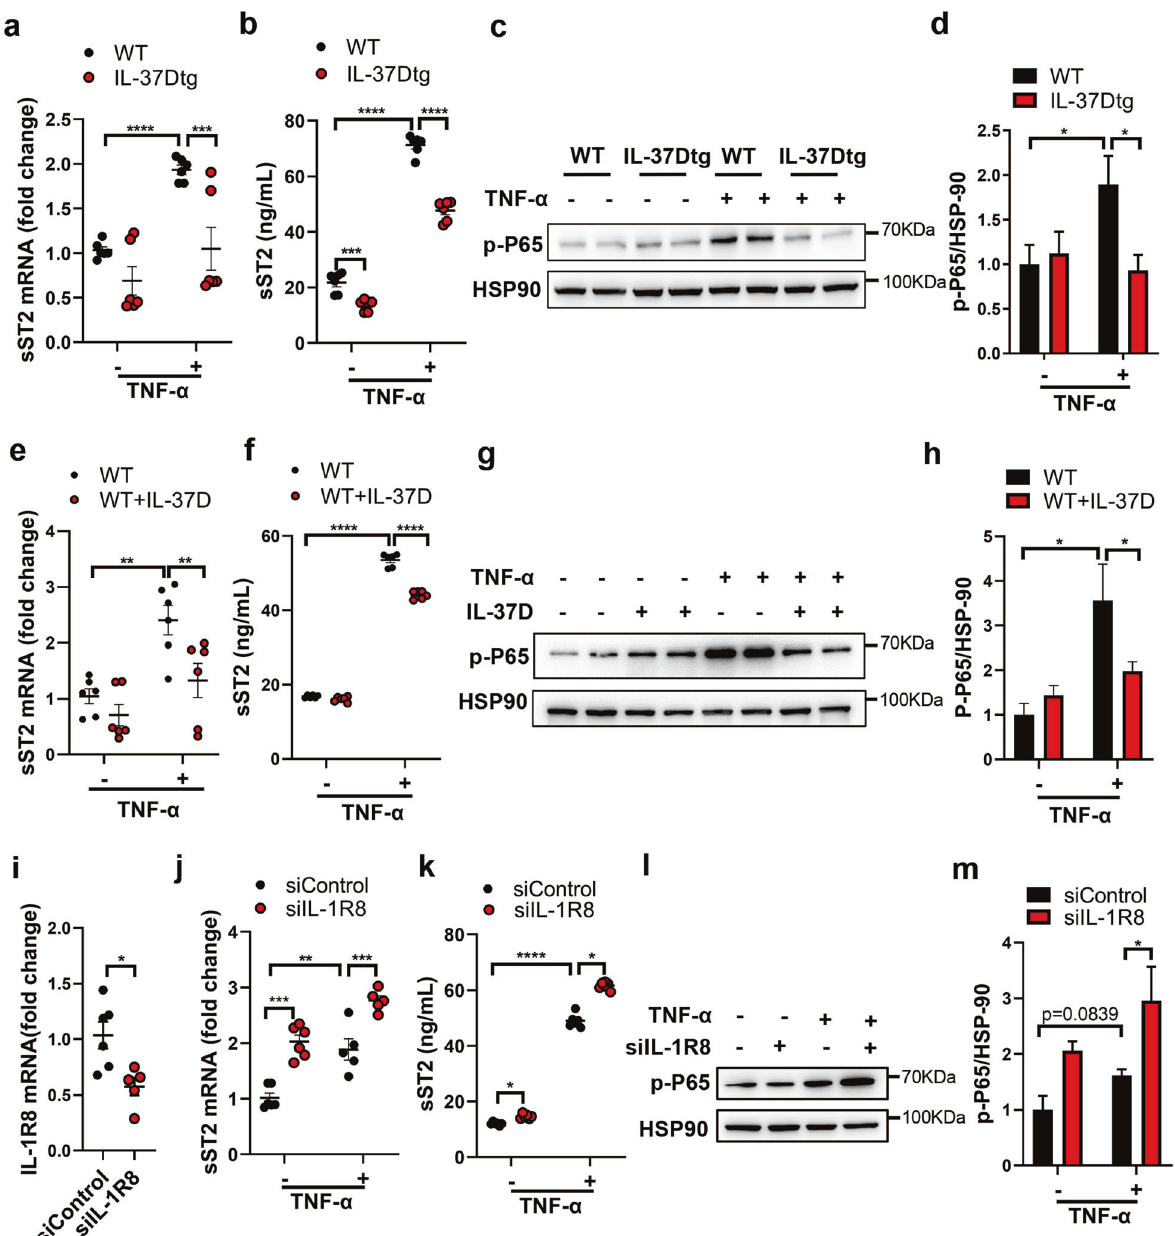
Fig. 7 IL-37D inhibits sST2 production in IL-1R8-dependent manner. a – d ADSCs (1 × 10 5 /mL) from inguinal WAT of WT and IL-37Dtg mice were stimulated by TNF- α (10 ng/mL) for 24 h. The mRNA ( a ) and secretion ( b ) levels of sST2 were detected by qPCR and ELISA. The protein level of p-P65 was detected by western blot ( c ), the grayscale values are shown ( d ). e – h ADSCs from inguinal WAT of WT mice were treated with IL-37D protein (1 ng/mL) in the presence or absence of TNF- α (10 ng/mL) for 24 h. The mRNA ( e ) and secretion ( f ) levels of sST2 were detected by qPCR and ELISA. The protein level of p-P65 was detected by western blot ( g ) and the grayscale values are shown ( h ). IL-1R8 was silenced in ADSCs from IL-37Dtg mice, the mRNA levels of IL-1R8 ( i ) and sST2 ( j ) were detected by qPCR, the secretion level of sST2 was detected by ELISA ( k ), and the protein level of p-P65 was detected by western blot ( l ) and the grayscale values are shown ( m ). Data in a – m are representative of three independent experiments. Data represent mean ± SEM. * p < 0.05, ** p < 0.01, *** p < 0.001, **** p < 0.0001 determined by two-way ANOVA ( a , b , d – f , h , j , k , m ) or student ’ s t test ( i ). Quantitative PCR Western blot assay Total RNA was extracted with TRNzol reagent according to the Proteins from lysed cells or tissues were separated on SDS-PAGE gel and manufacturer ’ s instruction (Tiangen, Beijing, China), and reversely tran- transferred onto PVDF membranes. After blocked with 5% bovine serum scribed into cDNA with PrimeScript ™ RT reagent Kit with gDNA Eraser albumin, the membranes were probed overnight at 4 °C with primary (TAKARA, Osaka Japan). Quantitative PCR was performed using FastStart antibodies against UCP-1 (Abcam, Cambridge, England), p-P65, IkB β (CST, Universal SYBR Green Master (Roche Applied Science, Penzberg, Germany). Boston, MA), HSP90 (ZSGB-BIO, Beijing, China), β -actin or β -tubulin Primer sequences for indicated genes are shown in Table S1. (Proteintech, Wuhan, China) followed by HRP-conjugated secondary